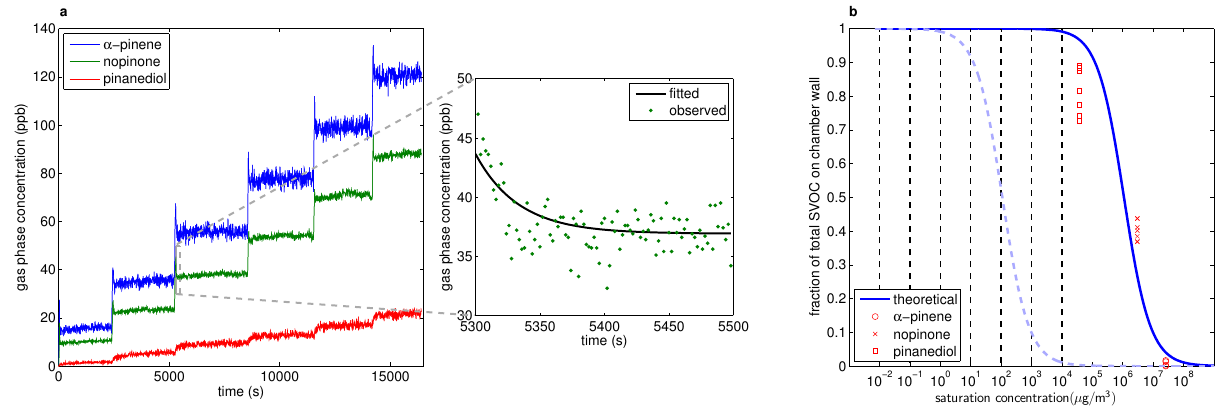
Fig. 2. (a) Time-dependent gas phase concentration of α -pinene, nopinone, and pinanediol. (b) Measured fractions of the same three com- pounds on chamber walls (red symbols), a theoretical extrapolation of the measurements to other volatilities (blue solid curve), and a the- oretical wall fraction assuming four orders of magnitude lower value for C w (blue dashed curve). The vertical dashed lines indicate the commonly assumed VBS volatility